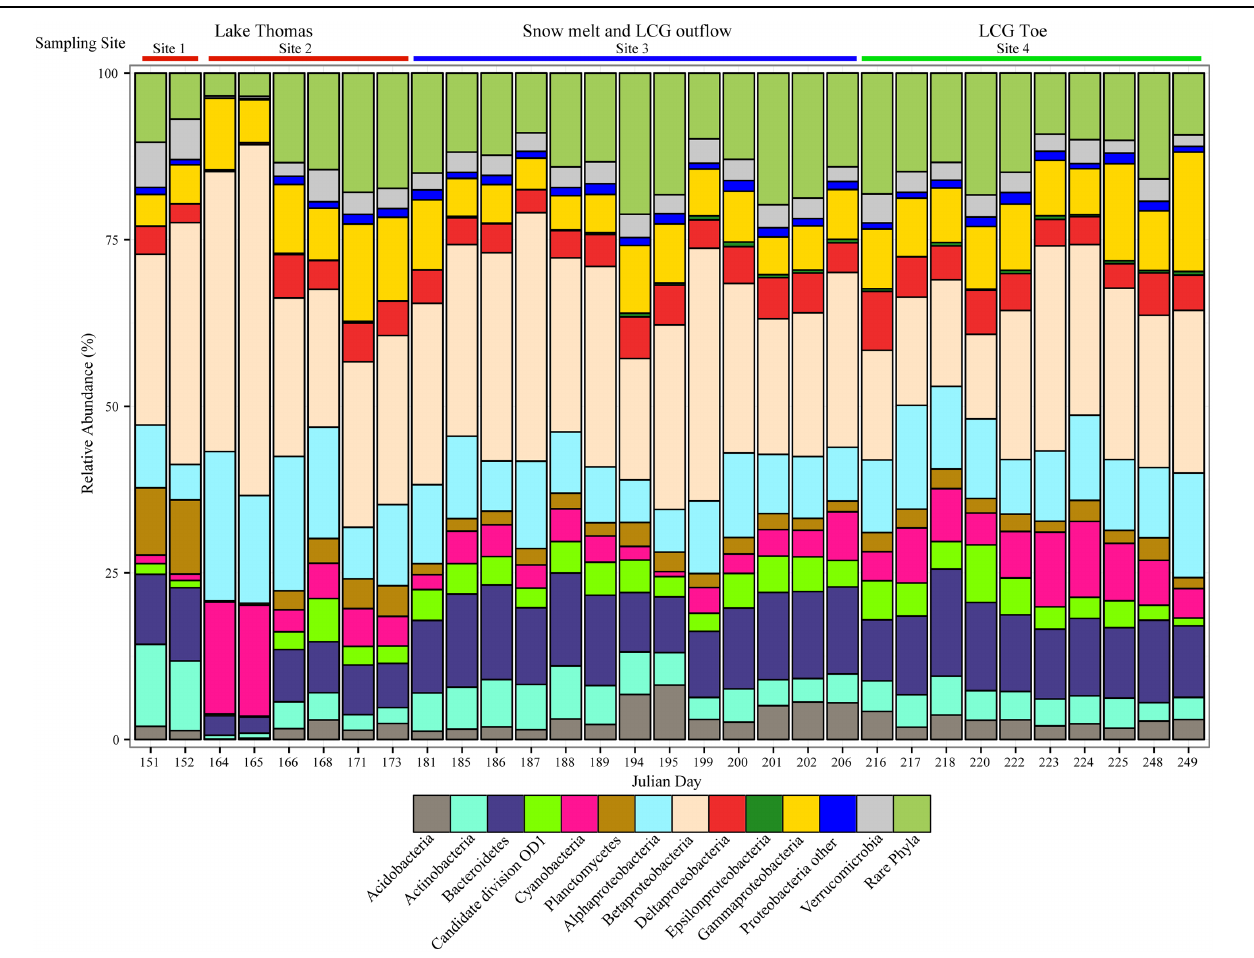
FIGURE 2 | Taxonomy of the top phyla and classes recovered in pyrosequencing libraries. Samples are arranged in chronological order from early (left) to late season (right). Colored bars above the graph indicate approximate sampling location. Taxonomy of OTUs 0 . 97 is based on the Silva v. 111